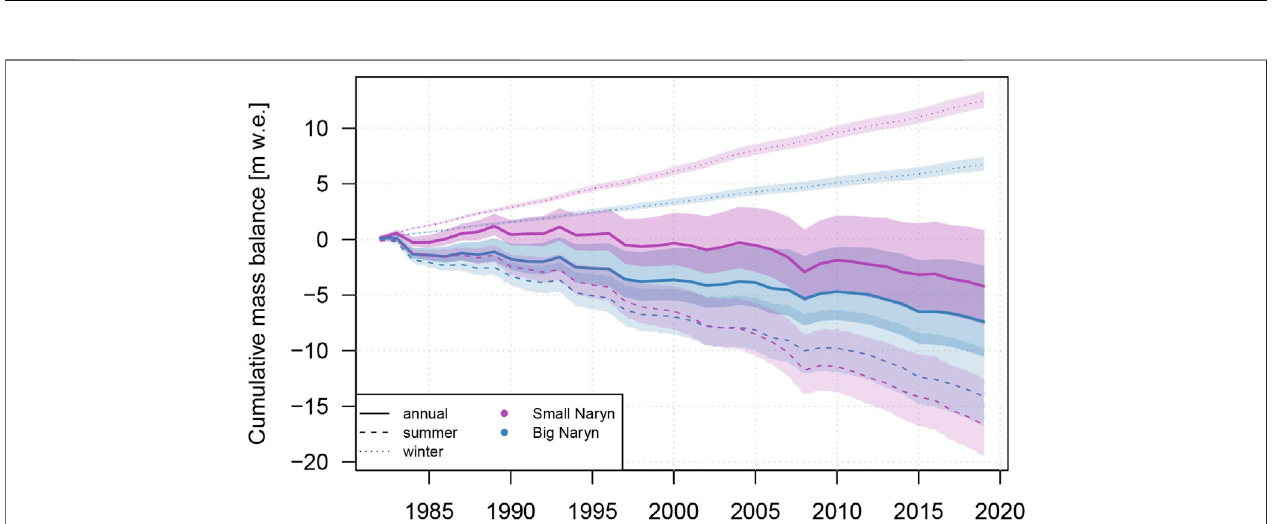
FIGURE 6 | Calculated cumulative seasonal and annual mass balance for glaciers in the Small and Big Naryn catchments.